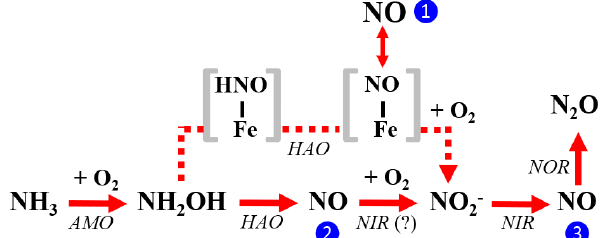
Figure 10. The three enzymatic pathways for NO production during NH 3 oxidation to NO − by AOB: the NH 2 OH obligatory interme- 2 diate pathway is indicated by blue circle 1, the NH 2 OH / NO oblig- atory intermediate pathway is indicated by blue circle 2, and the nitrifier-denitrification pathway is indicated by blue circle 3. Square brackets enclose proposed enzyme-bound intermediates [HNO-Fe] and [NO-Fe] of the NH 2 OH obligatory intermediate pathway. The role of AOB-encoded nitrite reductase (NIR) in catalyzing NO oxi- dation to NO − in the NH 2 OH / NO obligatory intermediate pathway 2 is hypothetical.